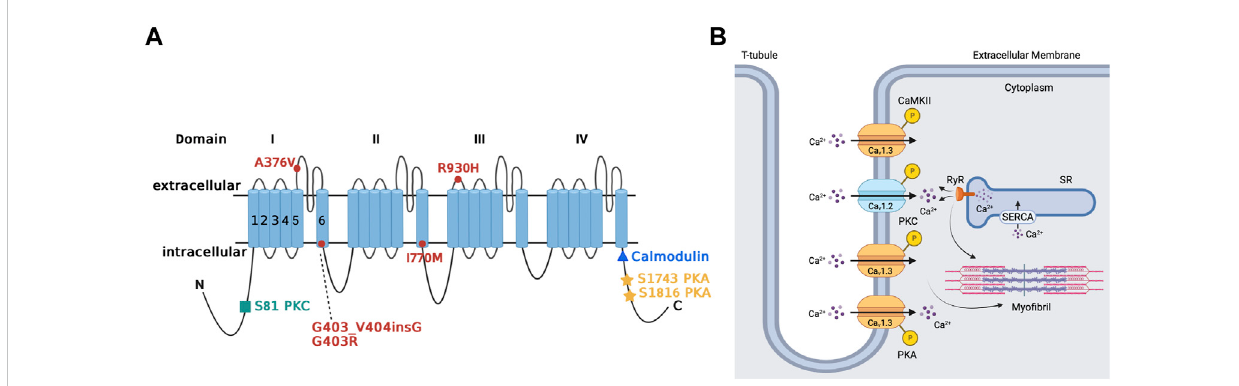
FIGURE 3 Regulation of Ca v 1.3 L-type Ca 2+ channel by protein kinase A, protein kinase C, and calmodulin-dependent protein kinase II. Panel (A) Schematic representation of the four homologous domains (I-IV) of the Ca v 1.3 α 1 -subunit with 6 transmembrane segments (S1-S6) and N- and C- termini. Phosphorylation of the channel by PKA is at serine residues located at positions 1743 and 1816 of the C-terminus. PKC phosphorylates at the N-terminal domain at serine residue located at position 81. Calmodulin binding site is on the proximal C-terminus. Missense variant A376V and the founder variant G403_V404insG, as well as heterozygous non-synonymous variant R930H in CACNA1D gene have been associated with sinoatrial node dysfunction (Liaqat et al., 2019; Rinné et al., 2022). The missense variants G403R and I770M has been found in patients with atrioventricular node dysfunction (Scholl et al., 2013). Panel (B) The sketch summarizes the regulation of atrial Ca v 1.3 channel by the different kinases, including PKA, PKC and CaMKII. Ca 2+ entry through Ca v 1.3 channel and subsequent Ca 2+ release from RyR contributes to pacemaking, while Ca 2+ entry